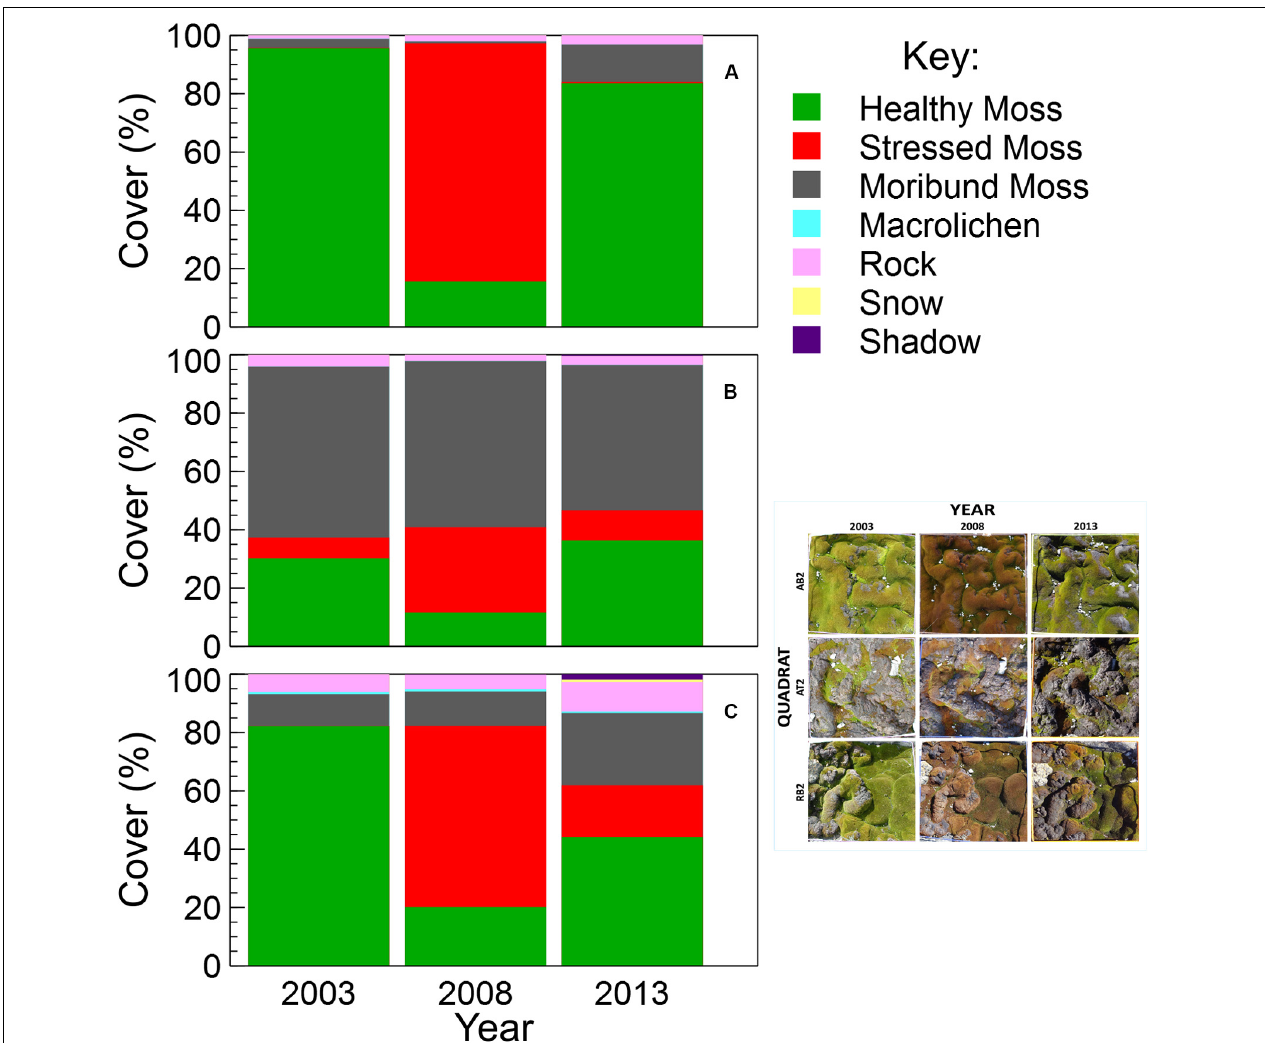
FIGURE 4 | Comparison of vegetation percent cover within each quadrat in the test mosaic ( Figure 1 ; inset at right): (A) AB2, (B) AT2, and (C) RB2, at 5-year intervals from 2003 to 2013, assessed using semi-automated object based image